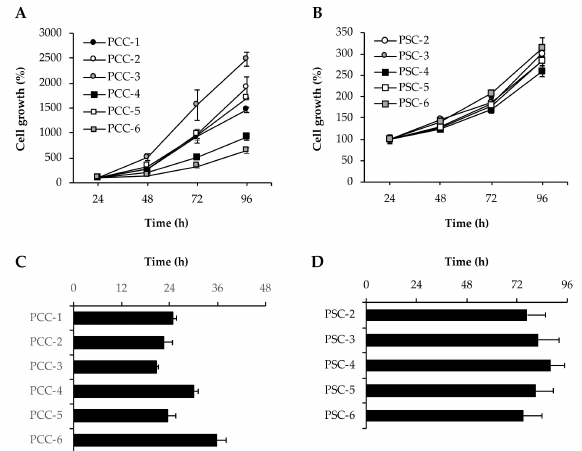
Figure 2. Assessment of growth: PCCs and PSCs seeded in 96-well plates individually were counted for cell number every 24 h for 4 days to determine growth curves ( A , B ) and doubling time ( C , D ). Data are mean ± SEM of triplicate determinations. PCC, pancreatic cancer cell; PSC, pancreatic stellate